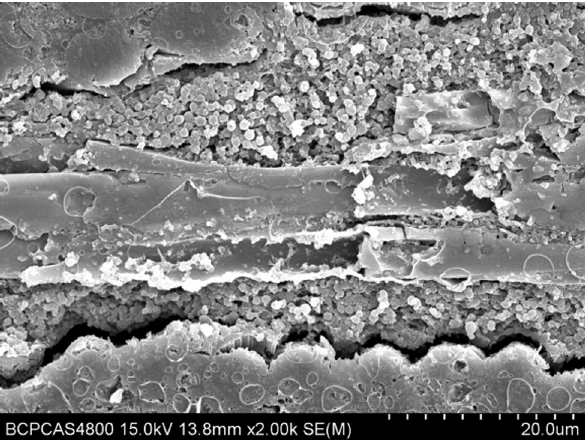
Figure 5: SEM of fracture surface of BMI matrix composite.